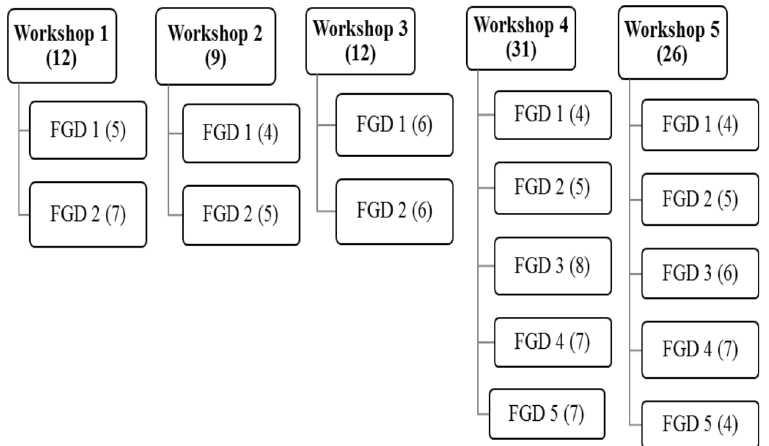
Fig 1. Flow chart representation of the two-stage consultation process (participant numbers in brackets).